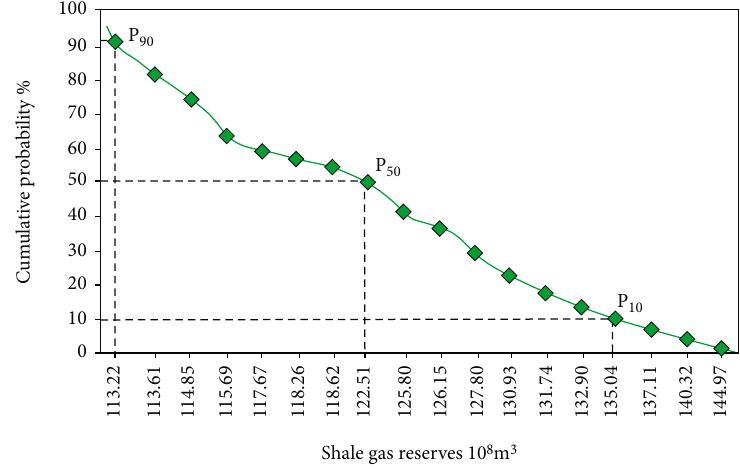
Figure 8: Cumulative probability distribution of shale gas reserves in JSB